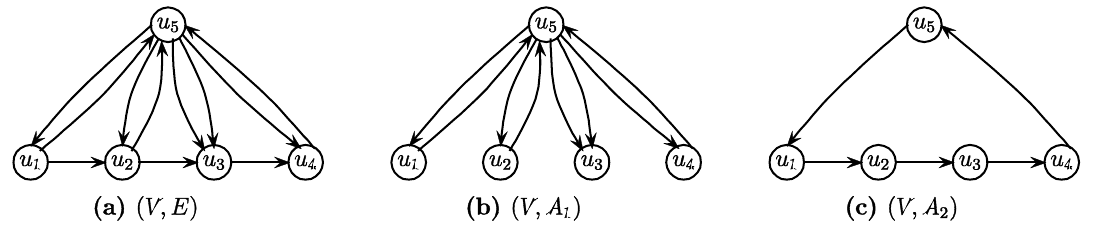
Figure 1. Illustrations of two valid solutions of M IN -E D on an input graph: ( a ) The original graph G = (V, E); ( b , c ) Two valid solutions (V, A The solution in ( c ) is optimal since it has fewer